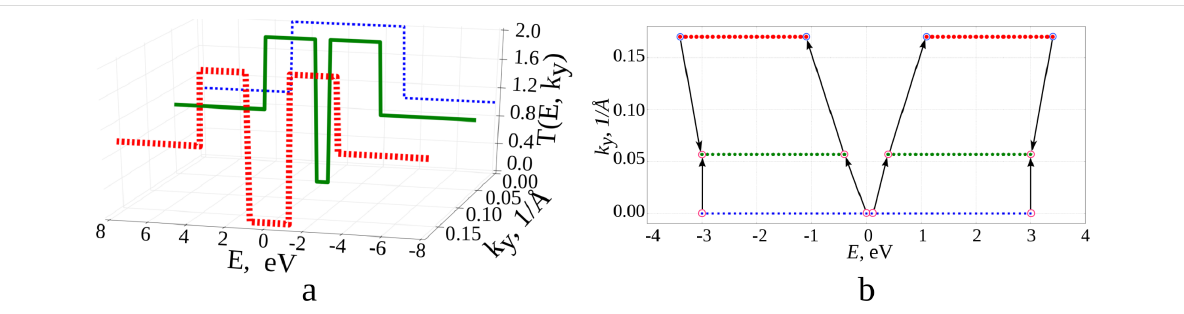
Figure 2: Transmission function: a) Т ( Е ) for three different k y ; b) the distribution of points of the transmission function for different energies and quan- tities k y for a fixed value of Т ( Е ) =